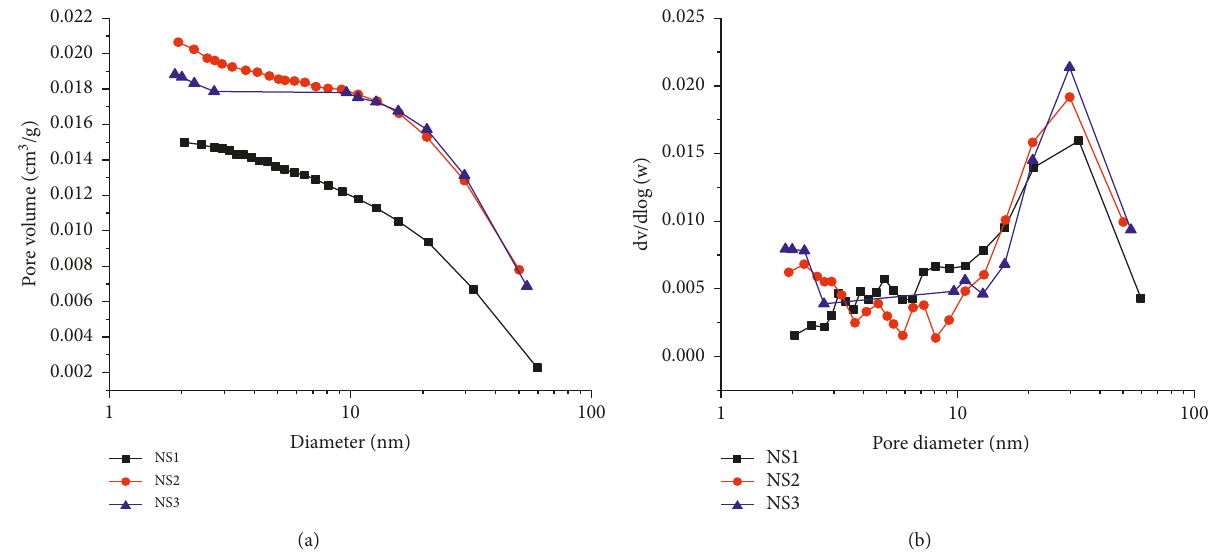
Figure 6: Pore size distribution of hardened cement paste by NS: (a) cumulative curve; (b) relative